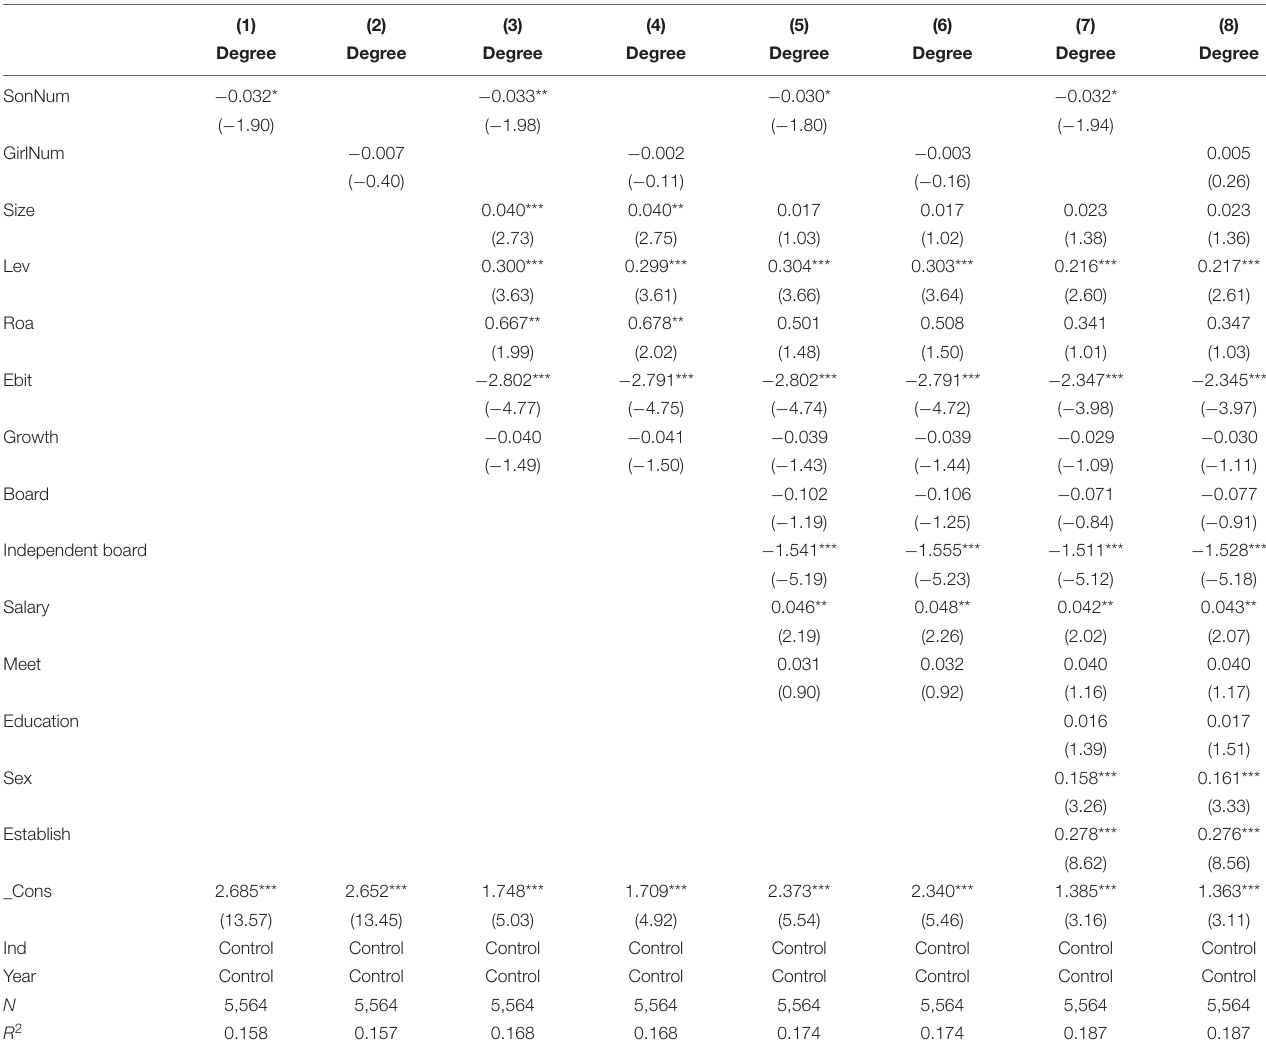
TABLE 11 | Number of sons, daughters, and